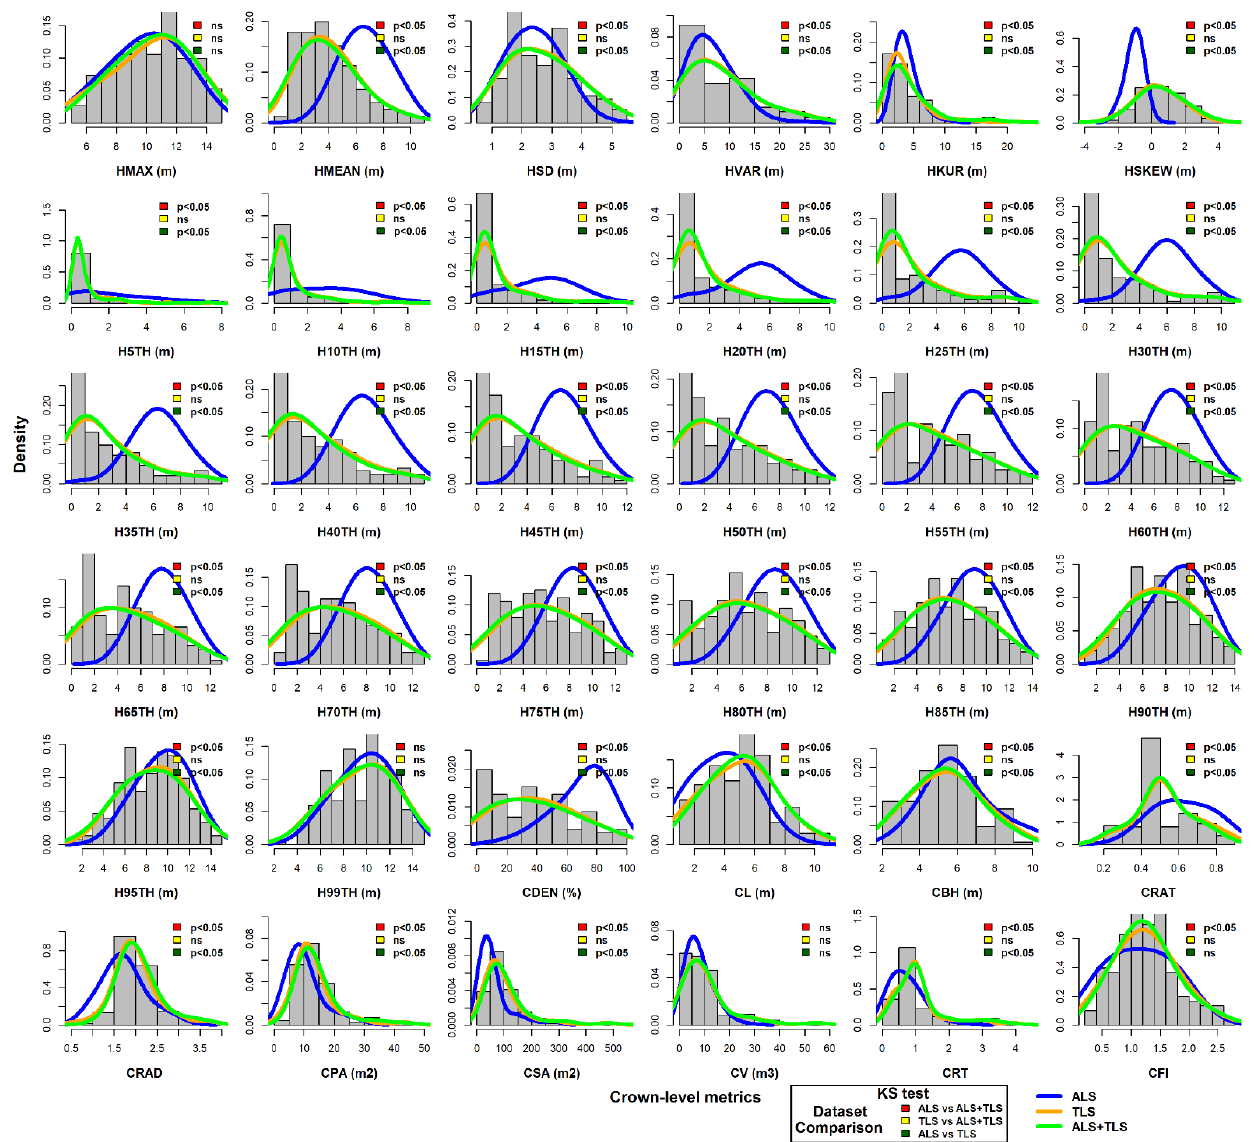
Figure 4. Density plot of the ALS (blue line), TLS (orange line), and ALS + TLS (green line) derived crown metrics. The red, yellow, and green squares represent the Kolmogorov – Smirnov test when comparing ALS vs. ALS + TLS, TLS vs. ALS + TLS, and ALS vs. TLS crown metrics distribution, respectively. The gray histogram is generated using the ALS + TLS crown metrics data. Ns refers to not significantly ( p > 0.05) in the two-sided Kolmogorov – Smirnov (KS) test.